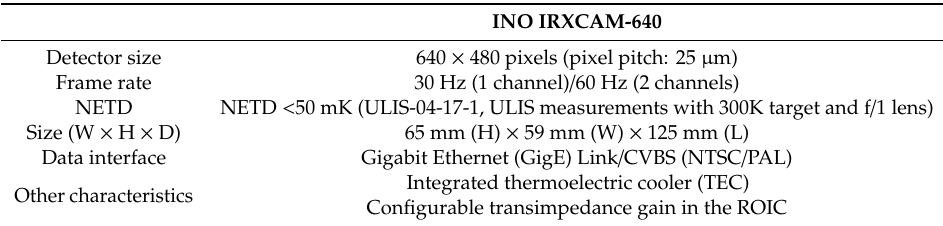
Table 2. Characteristics of the INO IRXCAM-640